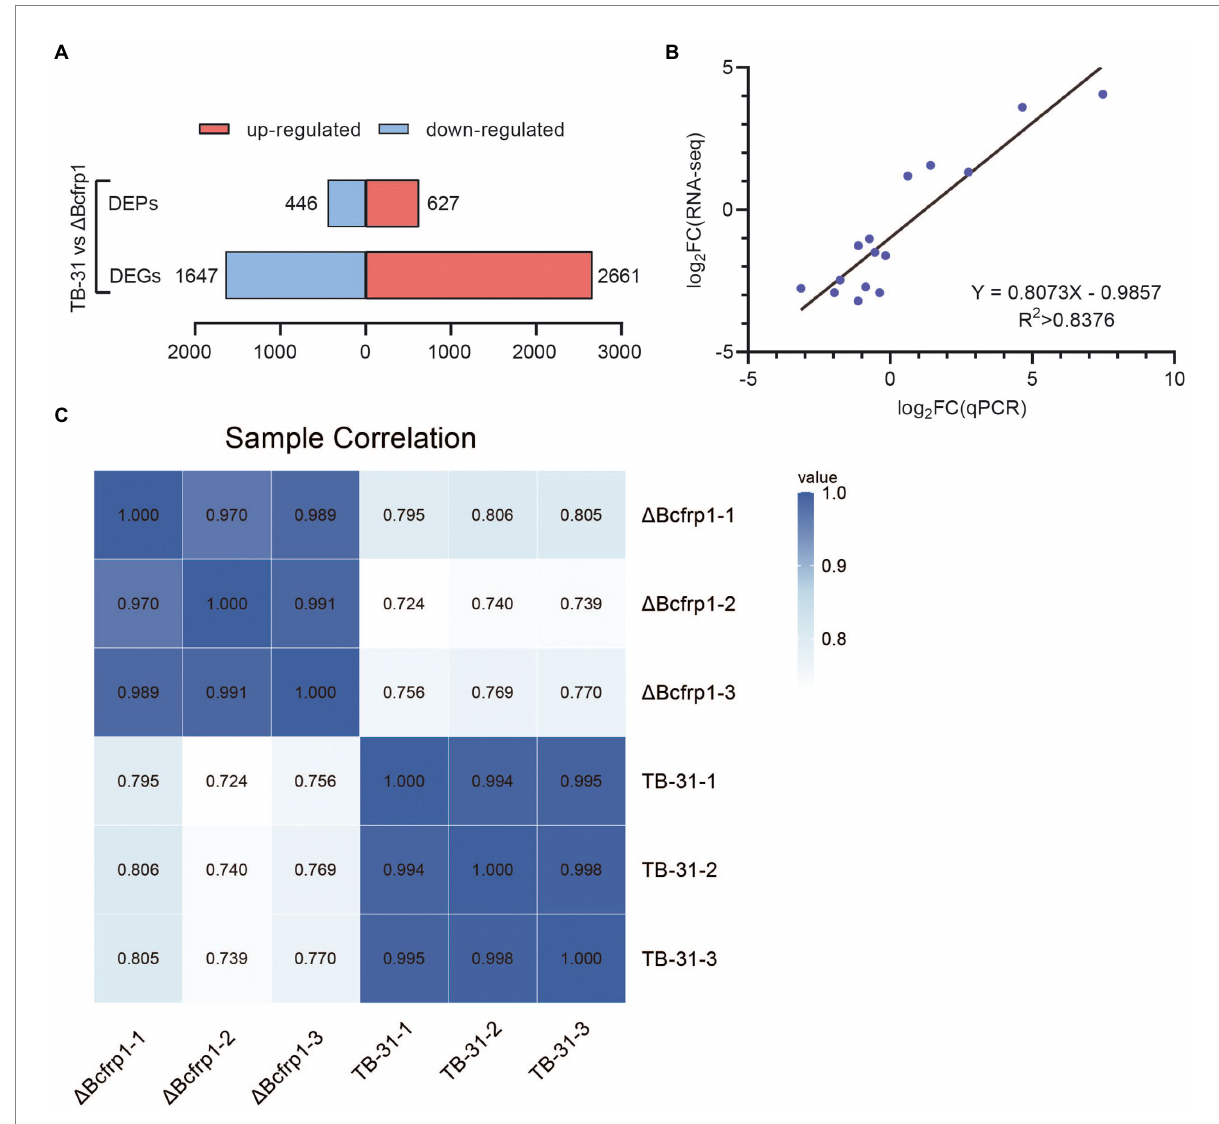
FIGURE 3 The transcriptomics and proteomics analysis of B. cinerea TB-31 and Δ Bcfrp1. (A) Histogram of differential gene and protein expression among different groups. (B) Regression analysis of gene expression levels determined by RNA-seq and RT-qPCR ( p < 0.05), rpearson = 0.8376. (C) The protein sample correlation heat map between the TB-31 and Δ Bcfrp1, pearson >